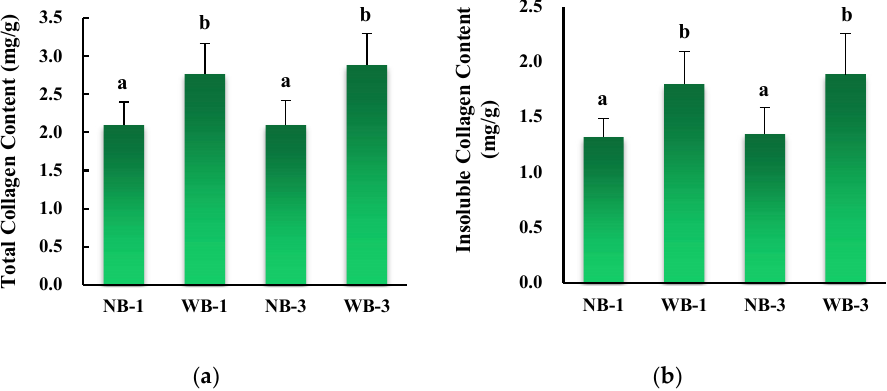
Figure 3. Total collagen ( a ) and insoluble collagen content ( b ) in wooden breast (WB) and normal breast (NB) muscles of broilers at day 1 and day 3 postmortem. Means without a common superscript (ab) differ; p < 0.05.